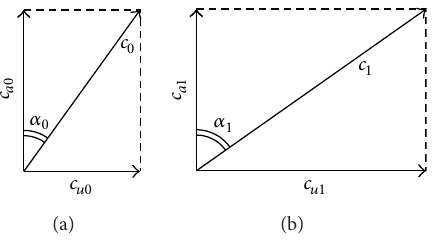
Figure 6: Velocity triangles at inlet (a) and outlet (b) of the annular